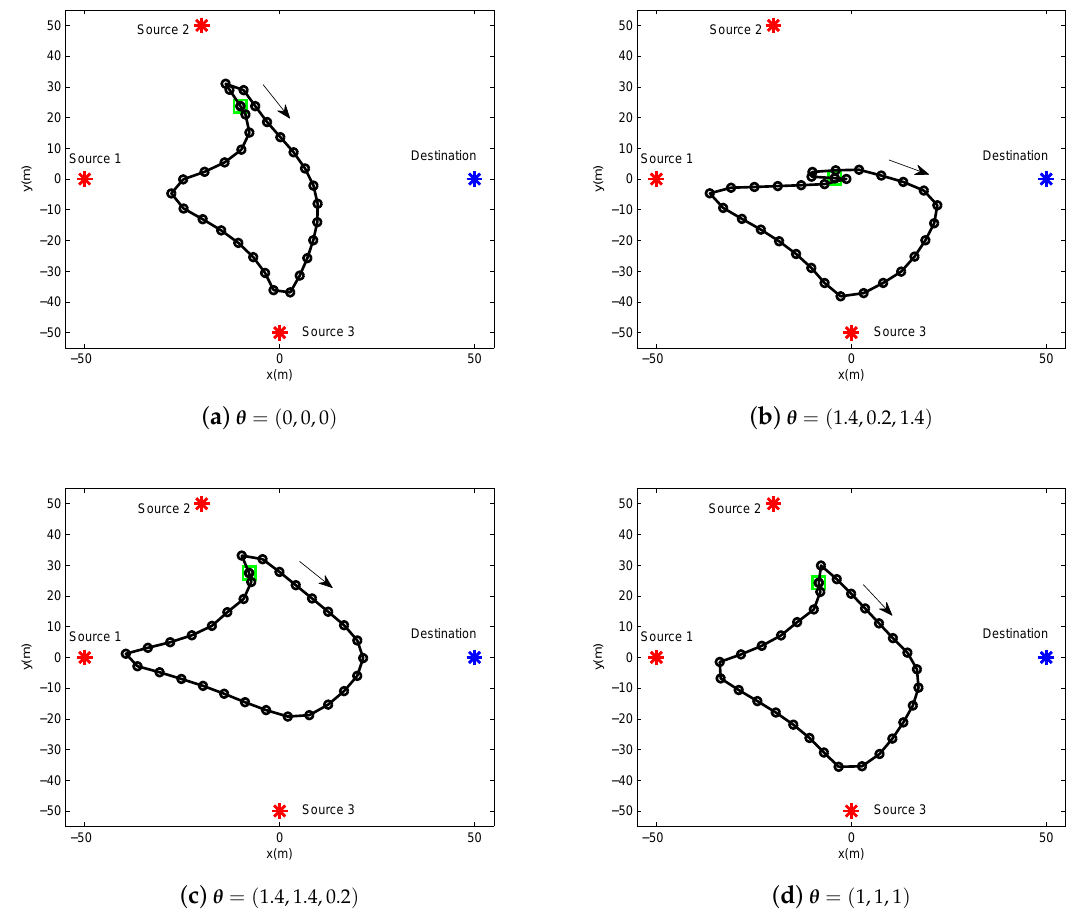
Figure 3. The trajectory of delay-tolerant case for period T = 60 s under different factor θ